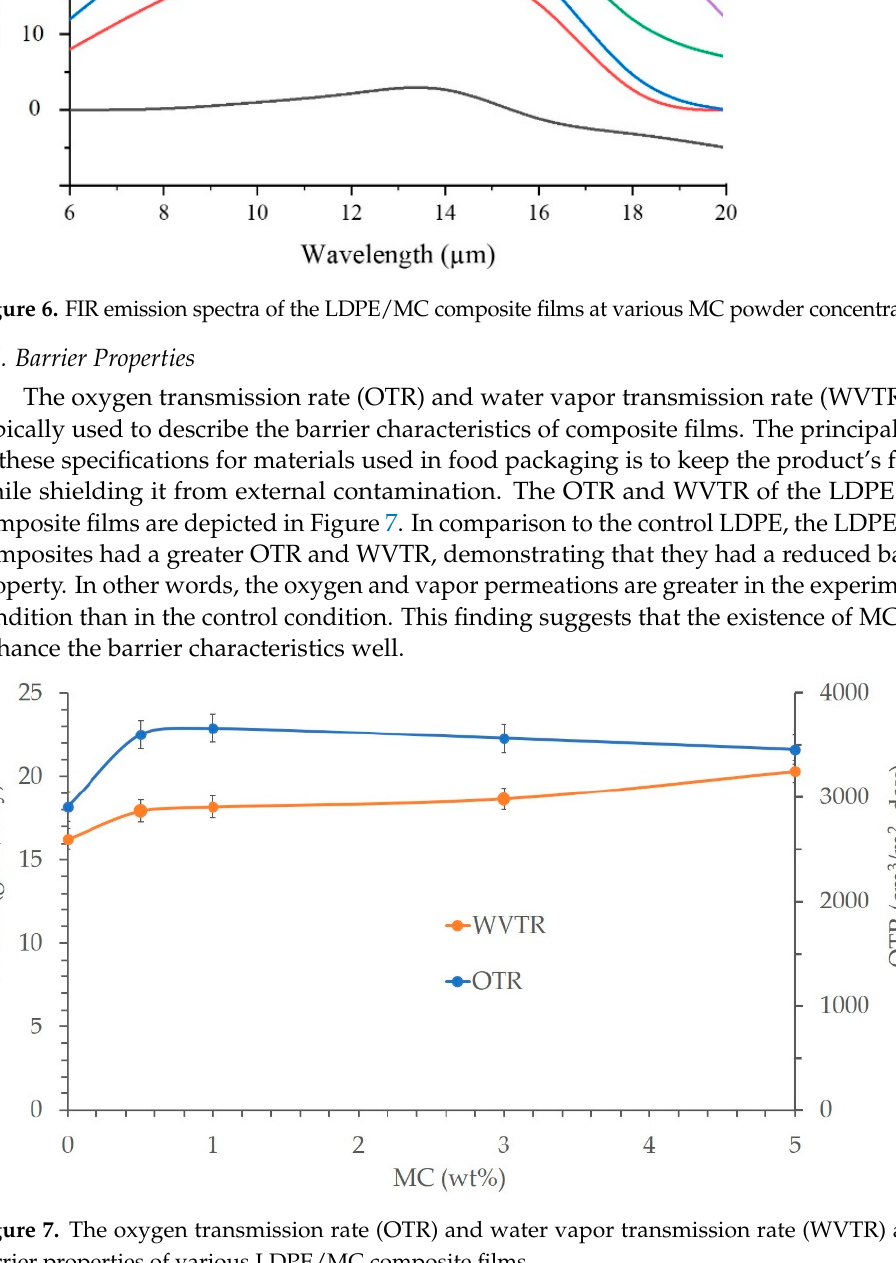
Figure 7. The oxygen transmission rate (OTR) and water vapor transmission rate (WVTR) as the barrier properties of various LDPE/MC composite films. 3.7. Light Transmission and Opacity Properties Figure 8 illustrates the light transmission and opacity of the LDPE/MC composite films. Light transmission refers to the percentage of incident light that travels through a film. Opacity is the property of a thin and clear material that allows it to conceal the